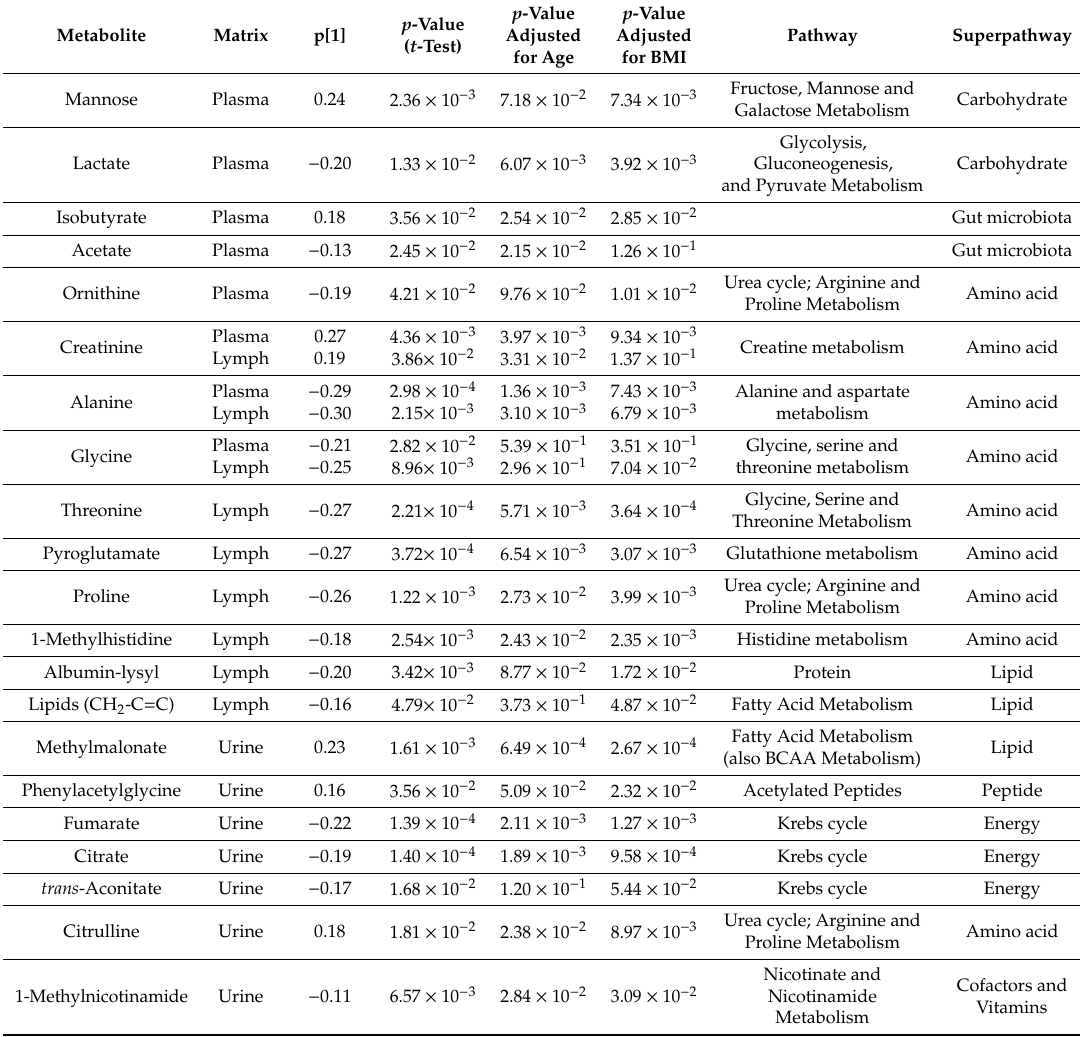
Table 2. Significant metabolites di ff erentiating hypertensive group from normotensive group in plasma, interstitial fluid, and